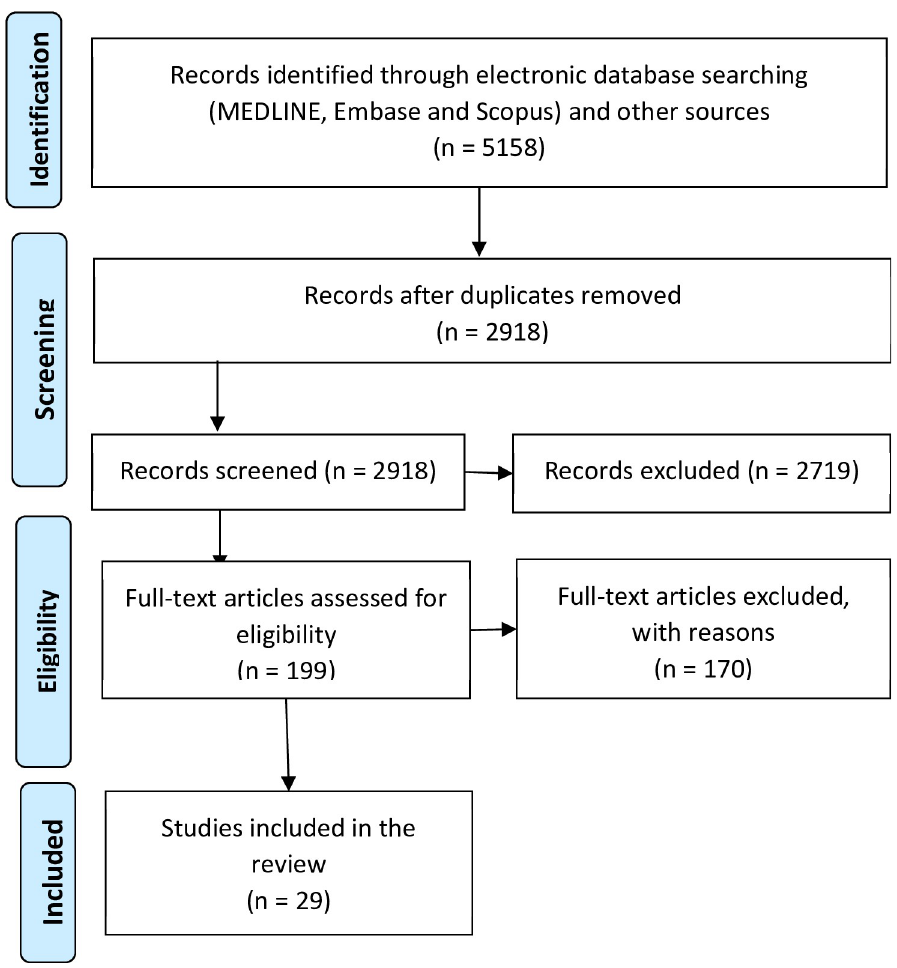
Fig 1. PRISMA flow chart on selection of included studies covered by the literature review.